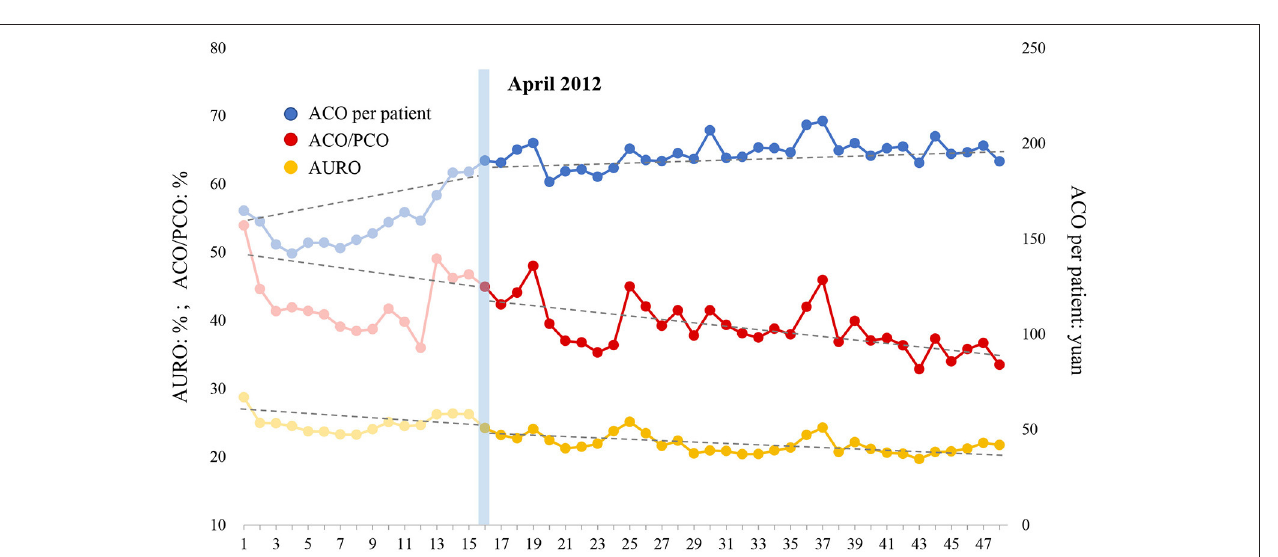
Frontiers in Public Health |